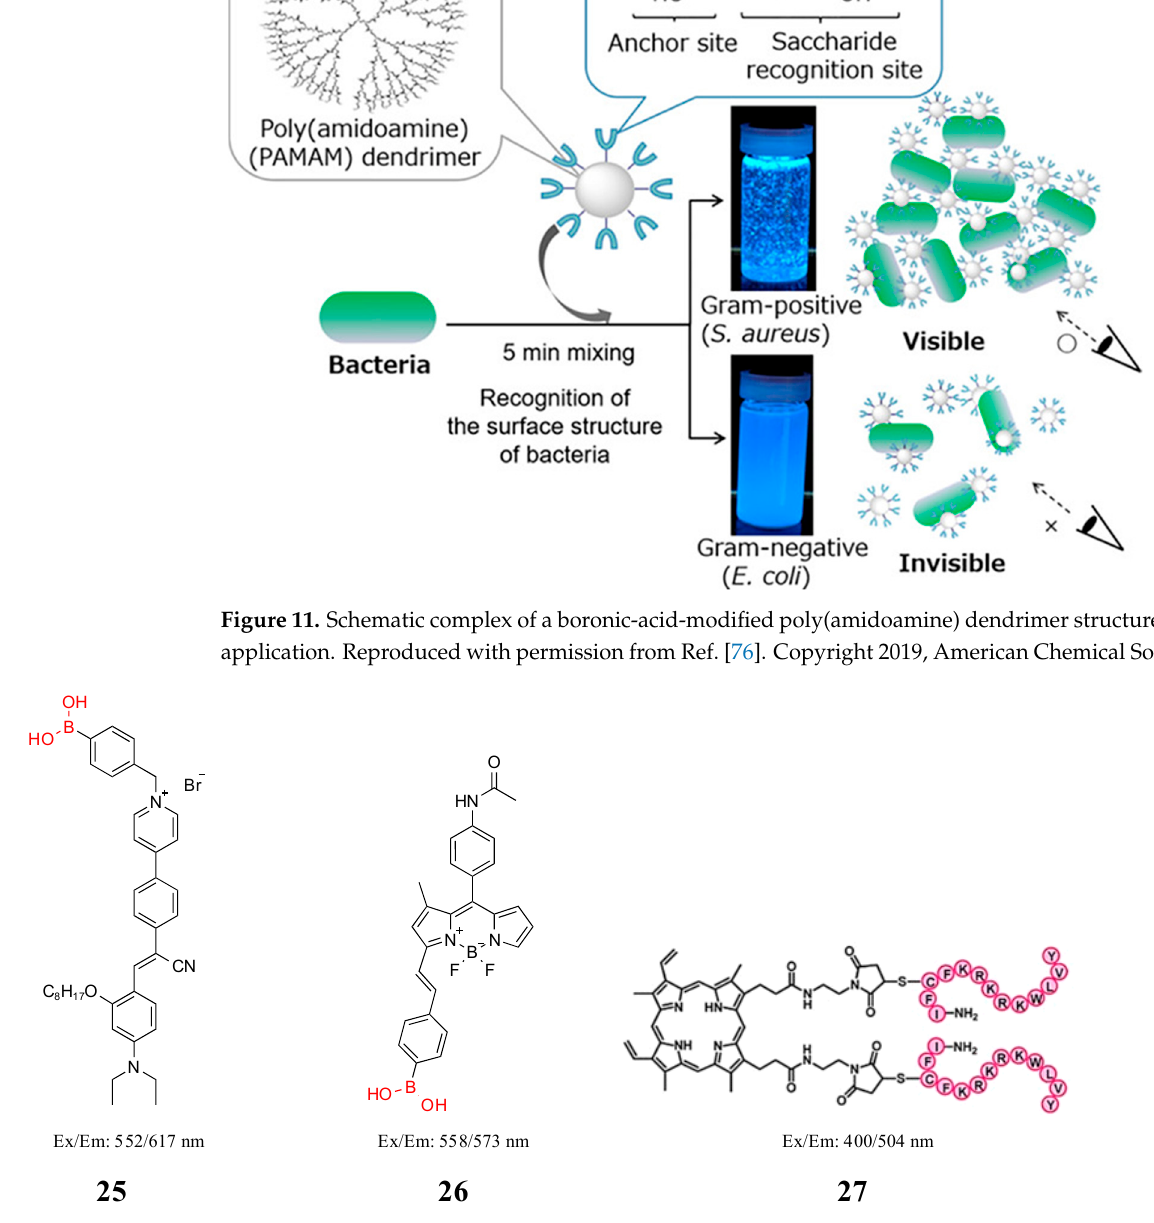
Figure 12. Structure of probes 25 – 27 . Reproduced with permission from Ref. [78]. Copyright 2012, American Chemical Society.